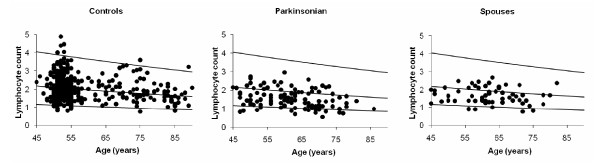
Contrast of lymphocyte counts (×109/l) in probands with idiopathic parkinsonism and their spouses with an age-specific 95% reference range based on routine requests. Counts are corrected as if all subjects were male, using the relationship to gender in controls, there being no evidence of an age.gender interaction.